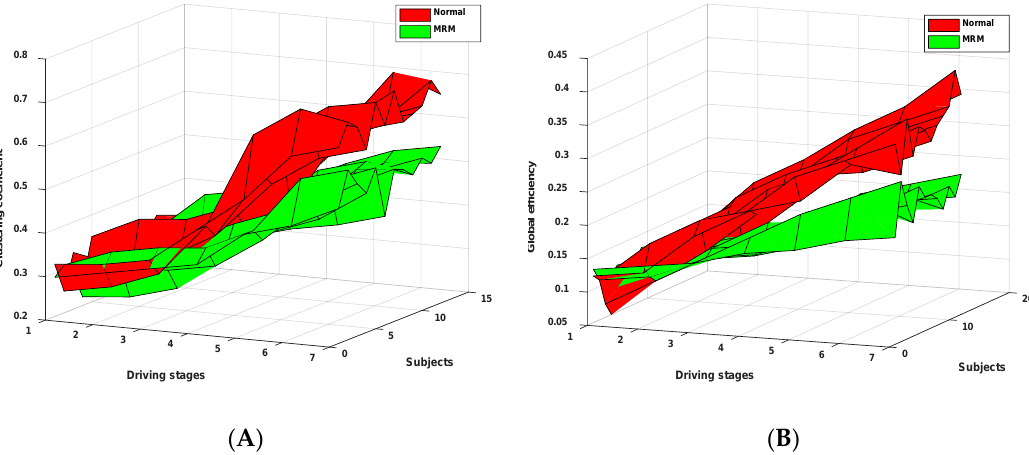
Figure 8. ( A ) Variation tendency of the cluster coefficient C at 7 driving stages; ( B )Variation tendency of the global efficiency G at 7 driving stages.